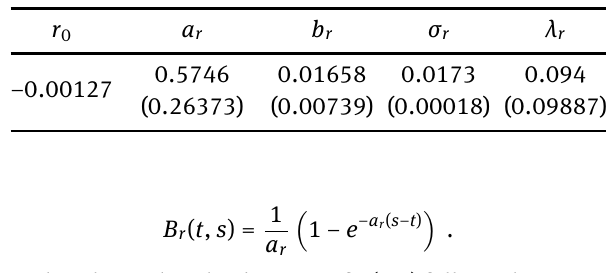
Table 2: Parameters of the interest rates for the complete model, obtained by the MLE method for the Ornstein-Uhlenbeck pro- cess with the corresponding standard errors between brackets, and by minimizing the residual sum of squares for the market price of interest rate risk with the corresponding minimum value between